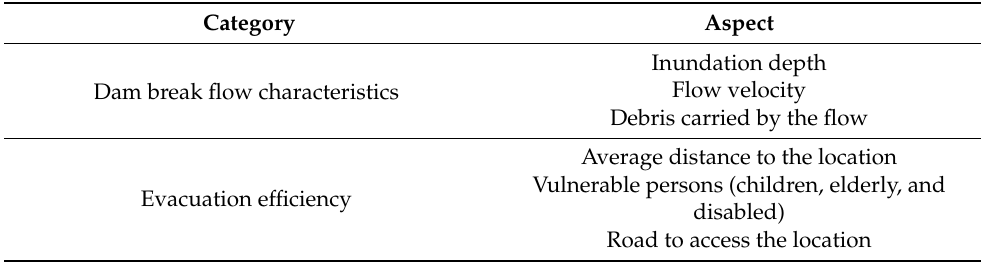
Table 2. Categories and aspects considered for flood risk mapping.